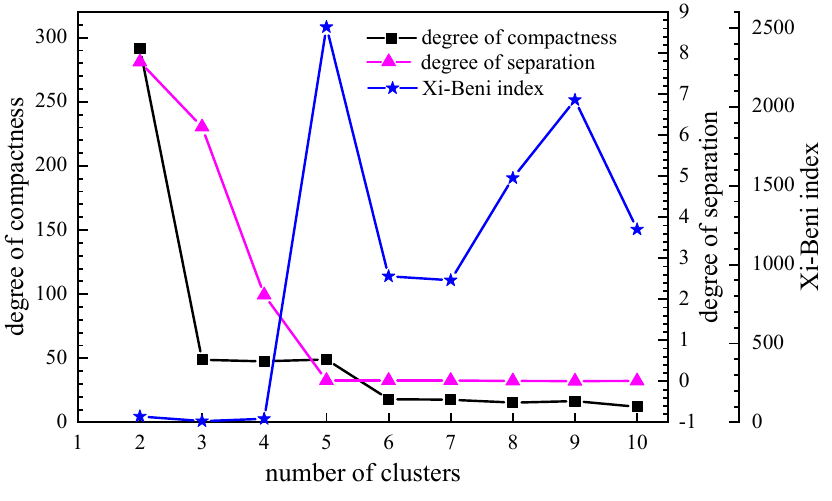
Figure 4. Compactness versus cluster number.